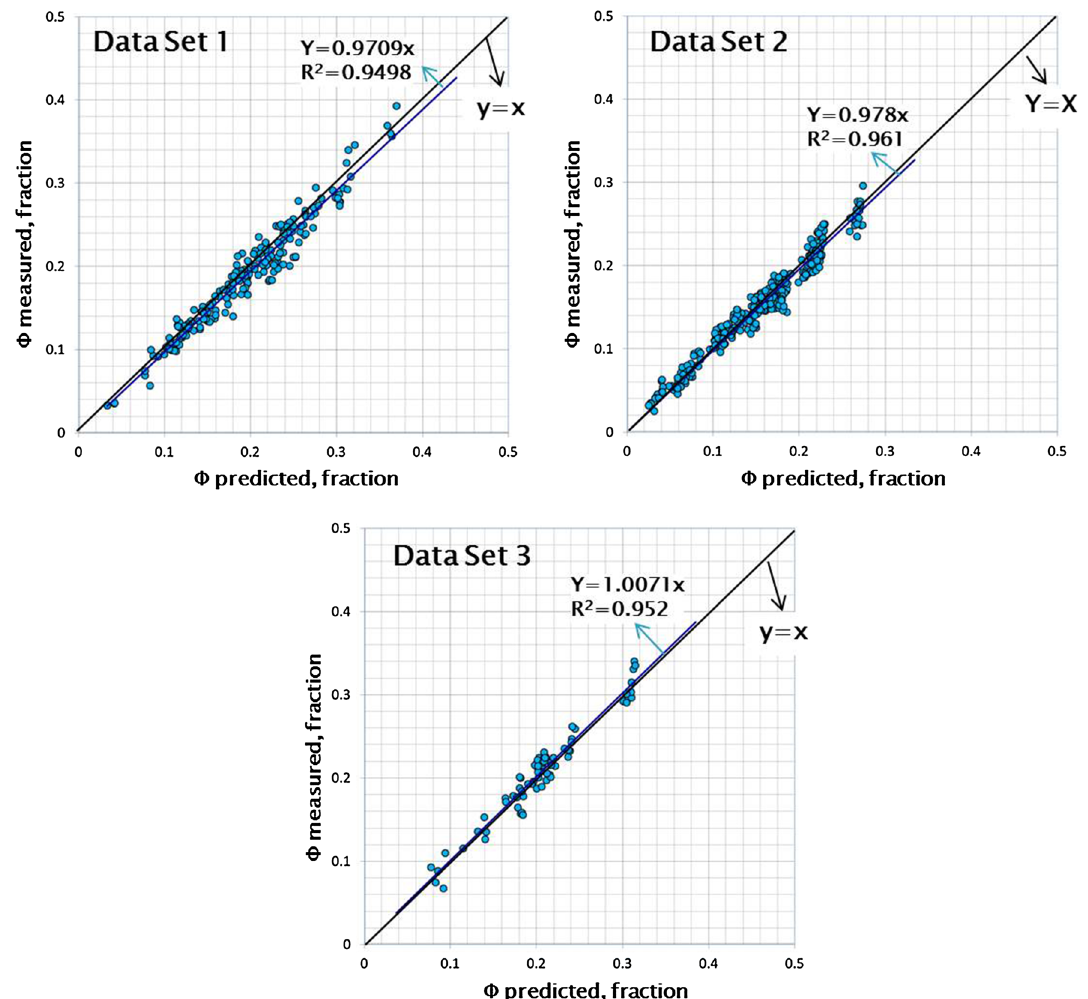
Fig. 7 Predicted versus measured porosity for data set 1, 2 and